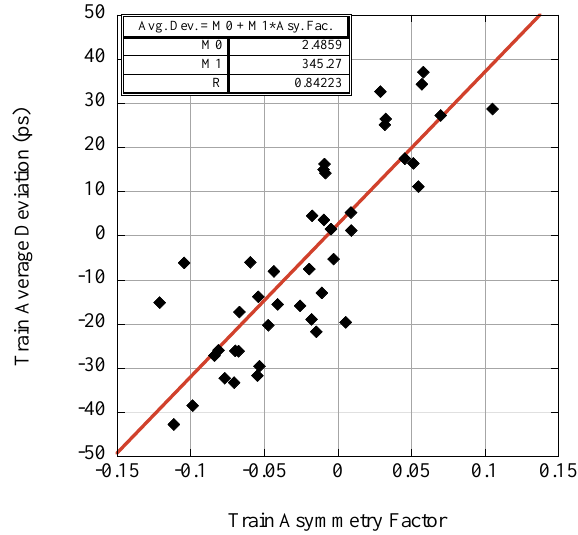
FIG. 22. (Color) A correlation between the train asymmetry fac- tor and the average time deviation.